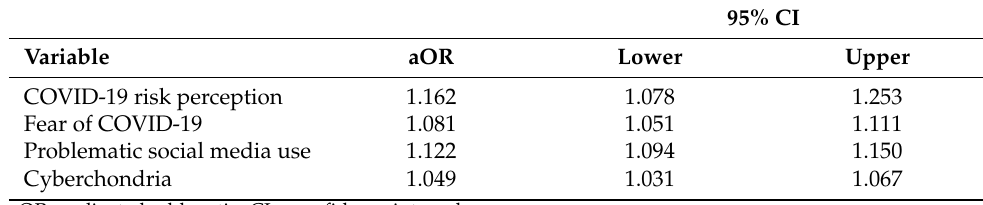
Table 4. Results of logistic regression model in explaining intention to get a COVID-19